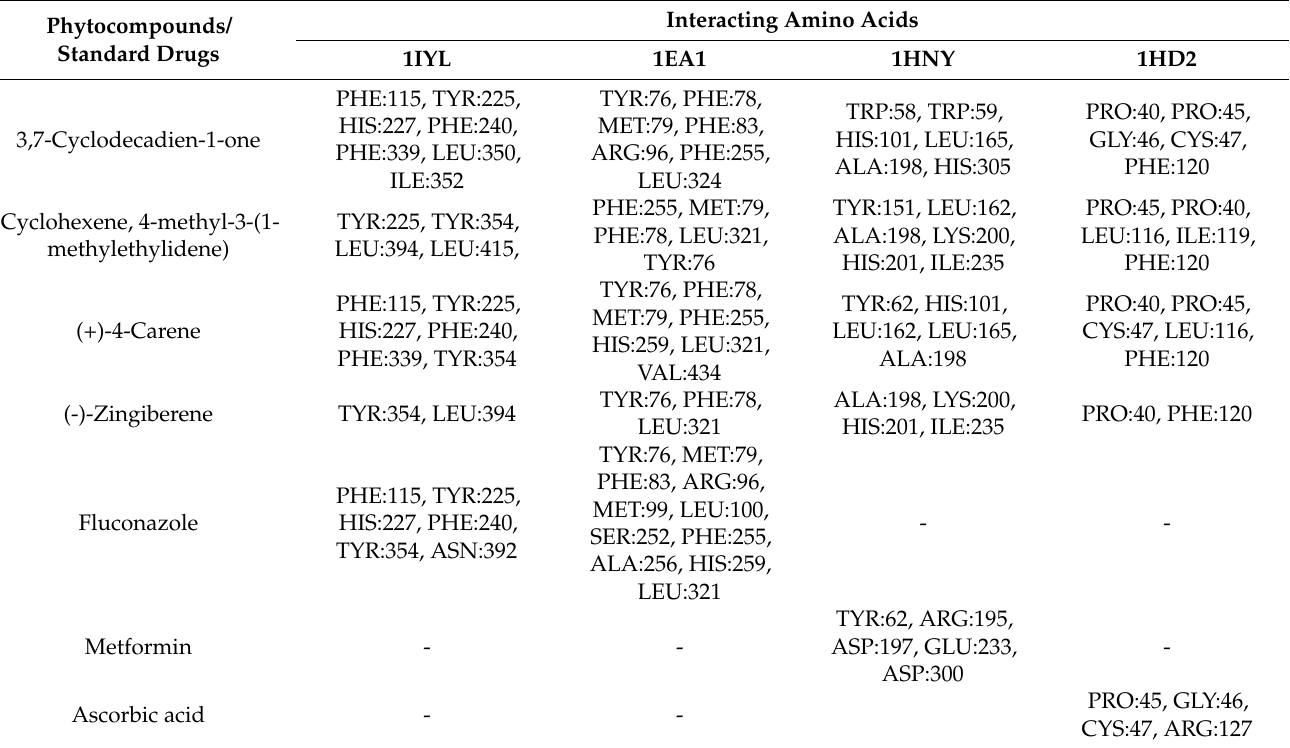
Table 5. Interacting amino acids of target proteins with selected phytocompounds and drug candidates.